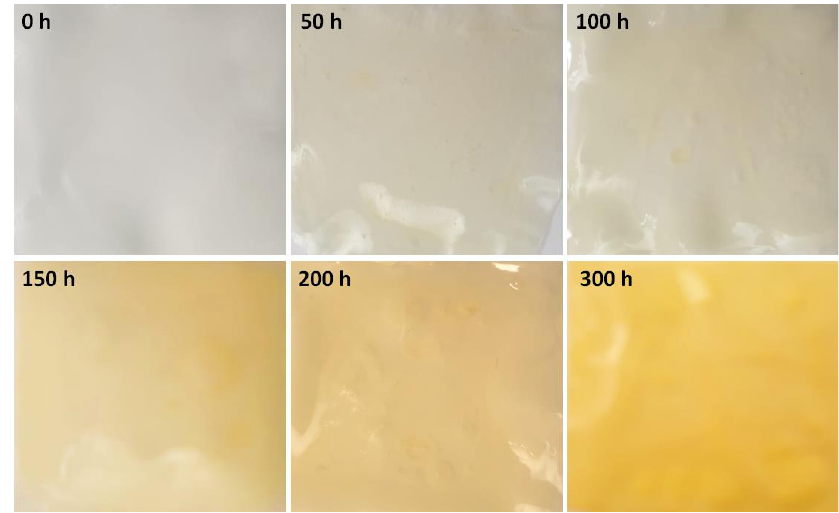
Figure 2. Color of PVC films after different irradiation times.